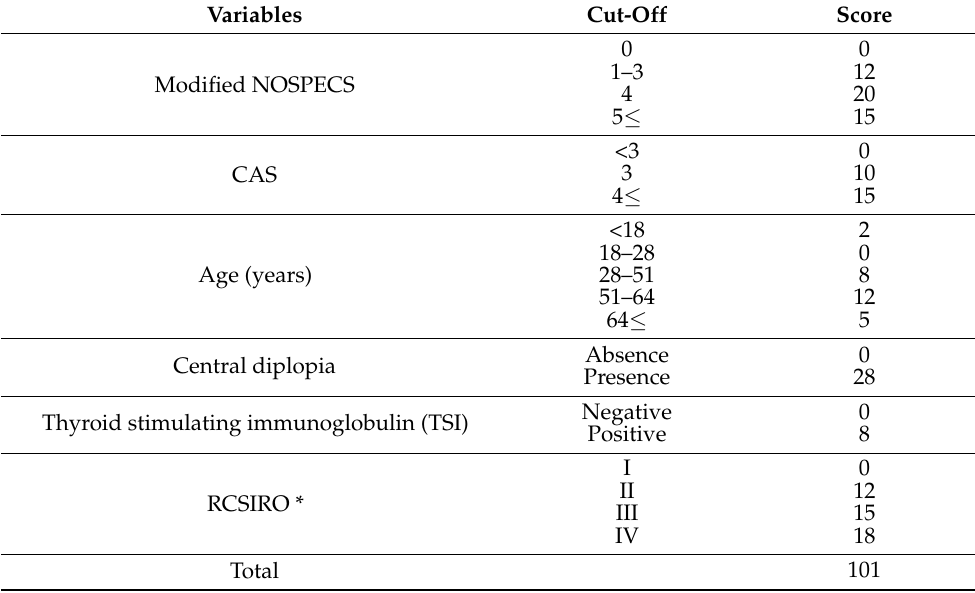
Table 2. The Score for Moderate to Severe type of Graves’ Orbitopathy Risk Prediction (SMSGOP) according to important variables.